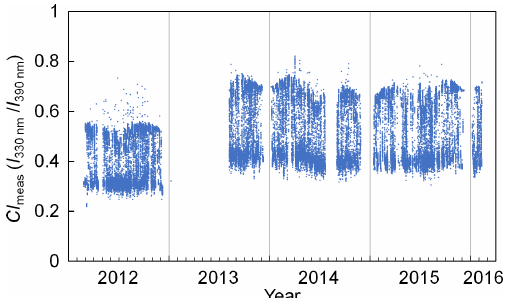
Figure A1. Time series of CI meas calculated from the zenith UV spectra measured during the entire study with 30 ◦ < SZA < 70 ◦ .